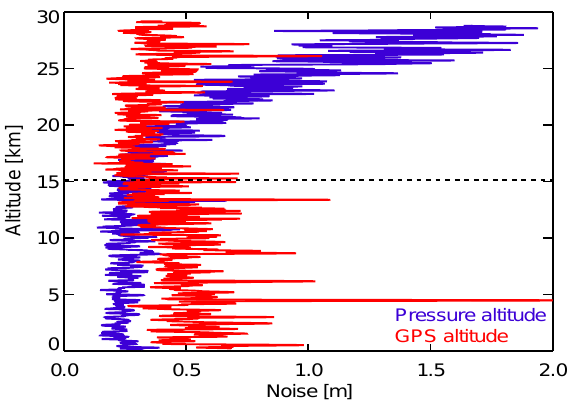
Figure 19. Noise of the geometric altitude derived from the pres- Fig. 19. Noise of the geometric altitude derived from the pressure sensor (blue) and the GPS sensor (red). sure sensor (blue) and the GPS sensor (red). The standard devia- The standard deviation is calculated using Eq. (A5) for a low-pass filter with a cut-off frequency of 0.067 Hz tion is calculated using Eq. (A5) for a low-pass filter with a cut- (corresponding to a period of 15 s ). The dashed black line indicates the altitude (15.1 km ) where the switch off frequency of 0.067Hz (corresponding to a period of 15s). The frompressure-basedtoGPS-basedaltitudeoccurs. ThesoundingwasperformedatLindenbergon17September dashed black line indicates the altitude (15.1km) where the switch 2013, 12:00UTC. from pressure-based to GPS-based altitude occurs. The sounding was performed at Lindenberg on 17 September 2013 at